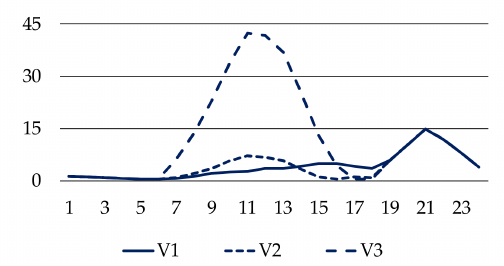
Figure 19. Daily simulation results showing the energy losses (kWh) for variants V1, V2, and